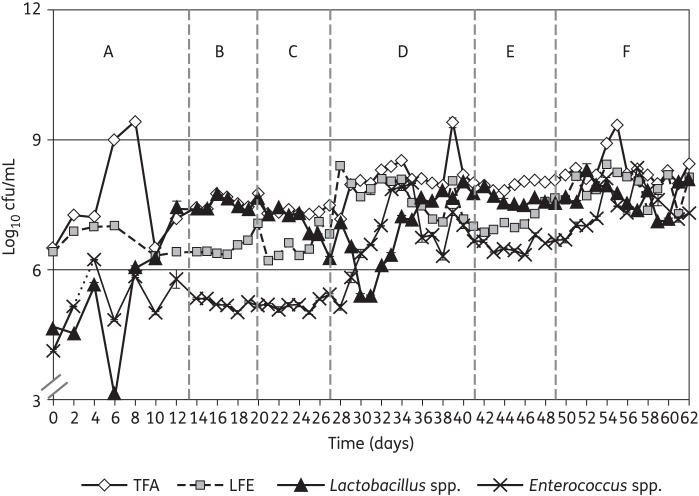
Mean viable counts (±SE) of facultative anaerobe bacterial groups (log10 cfu/mL) in vessel 3 of the SMT19969 250 mg/L/day gut model (period E). TFA, total facultative anaerobes.